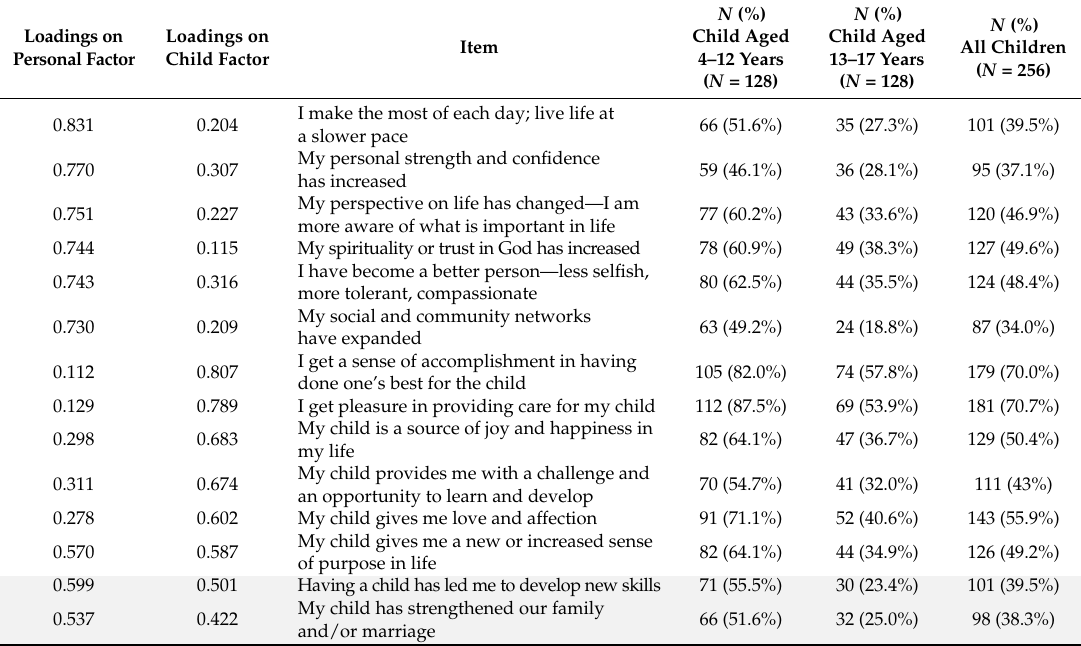
Table 3. The item loadings on the two factors and the frequency and percentage of the items which parents rated as ‘strongly agree’ based on the child’s